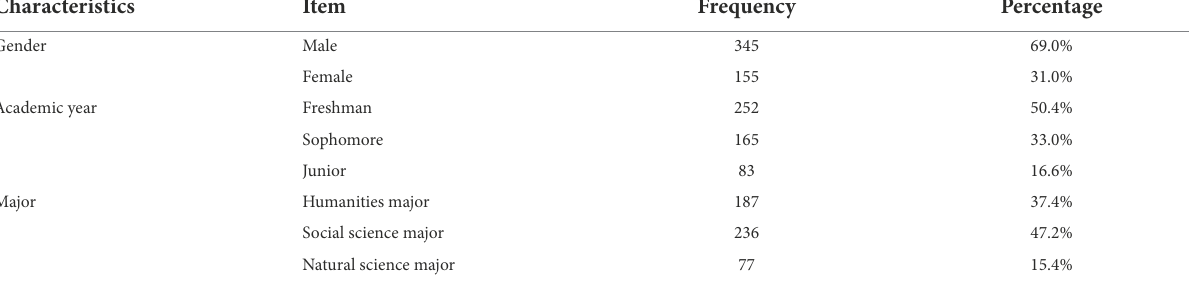
TABLE 1 Demographic information of the sample.